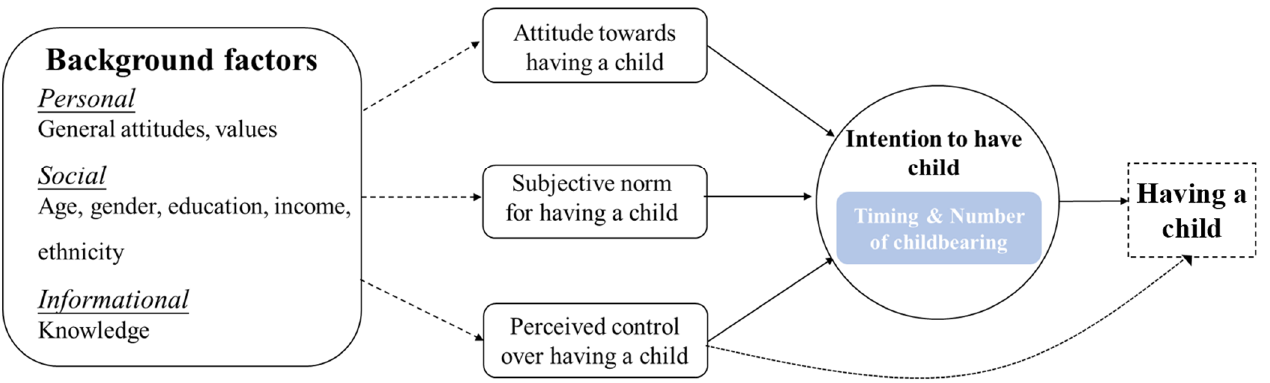
Figure 1. Theory of planned behavior applied to fertility intentions.